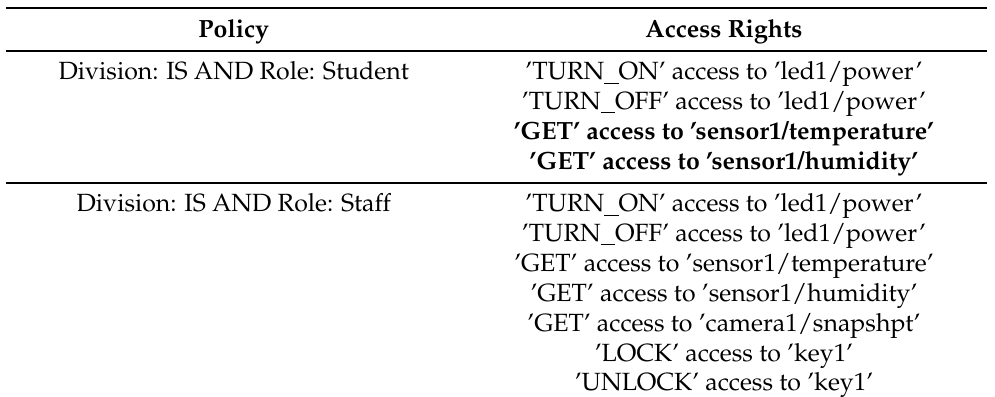
Figure 8. Example of access right update. Table 2. Policies and access rights after